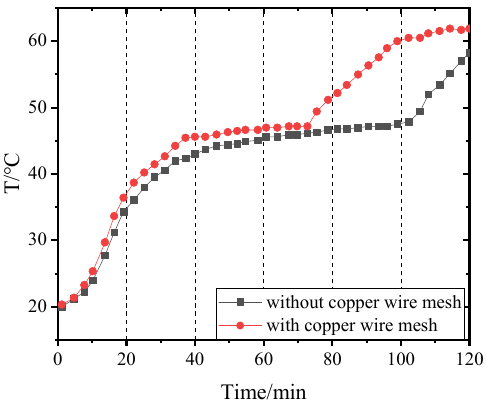
Figure 14. Temperature of point 1 in PCM-1 changing with time.